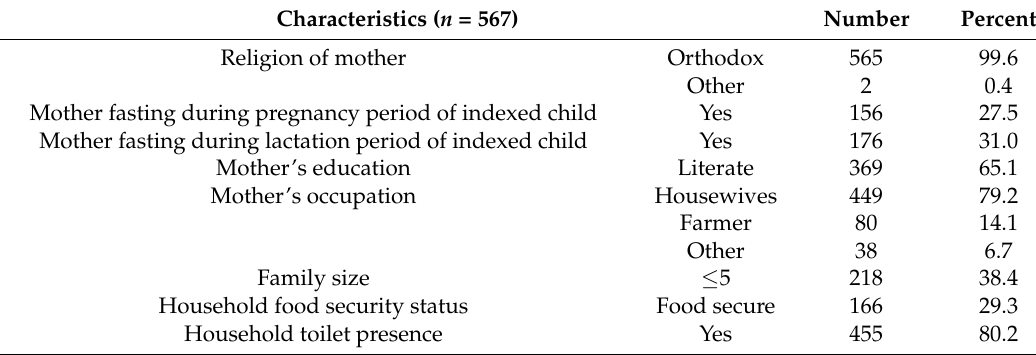
Table 1. Socio-demographic and economic characteristics of the study participants ( n = 567) in rural Tigray, Northern Ethiopia (February–June,